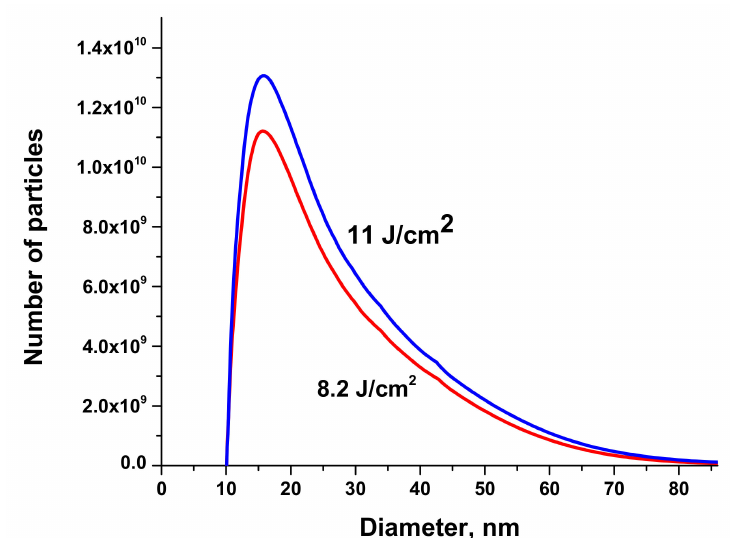
Figure 7. Size distribution of Au NPs generated by ablation of a bulk Au target in H 2 O at various fluences on the surface of target. Laser fluence is indicated at each curve. Size distribution was determined using disk measuring centrifuge. Copied from reference [25] with copyright permission from Journal of Physics of Wave Phenomena Springer publisher. One can see that most of Au NPs have the diameter between 15 and 20 nm. Their colloidal solution in H 2 O was used in further laser synthesis of nanocomposites BTO-Au.